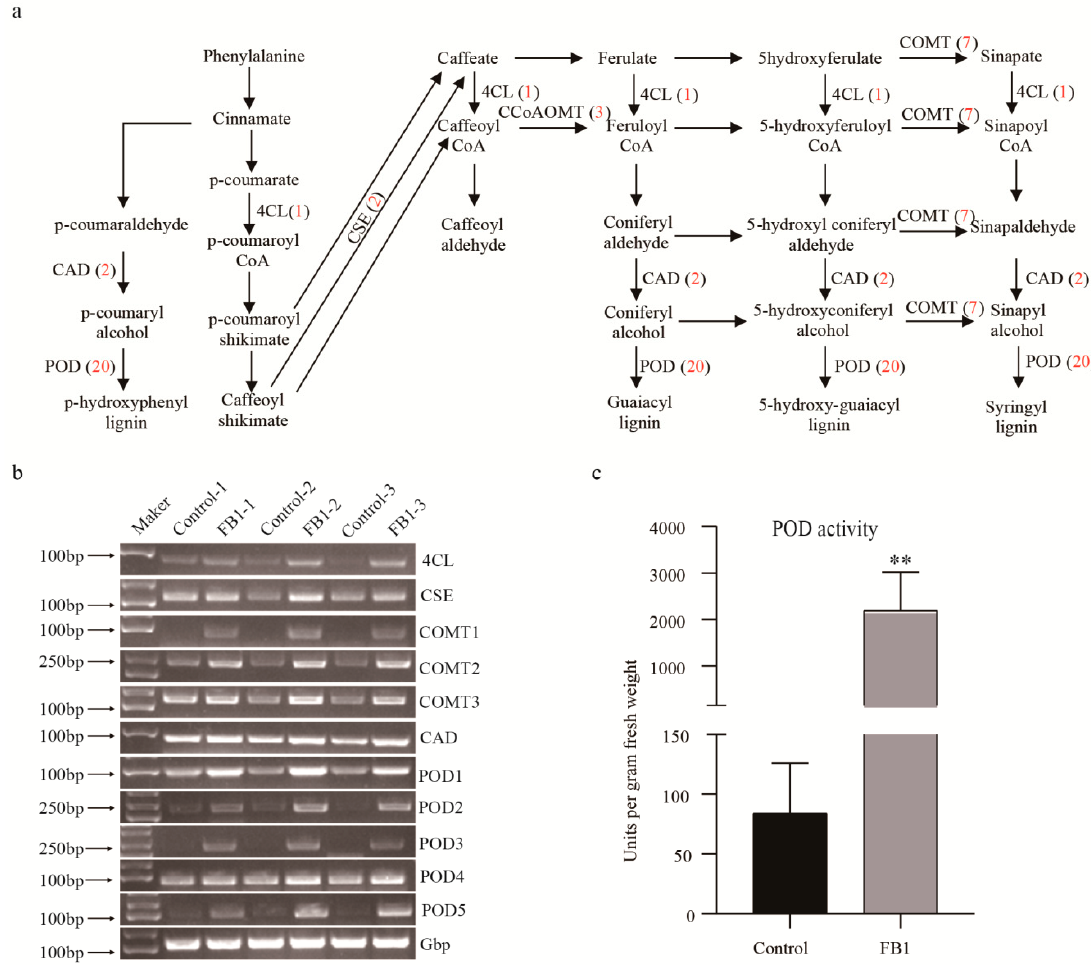
Figure 6. Involvement of the phenylpropanoid biosynthesis [33] in cotton fibers and ovules treated by FB1. ( a ) Up-regulated proteins from the phenylpropanoid biosynthesis pathway. The numbers in red represent proteins up regulated at the FB1 treated samples. ( b ) Semi-quantitative PCR of the phenylpropanoid biosynthesis-related genes in control and the FB1 sample. DL2000 DNA marker (left). Amplified genes of interest (right). ( c ) POD activity of control and the FB1 sample. Double asterisks indicate statistically significant differences between FB1 treatment and the control, as determined by Student’s t-test (**, p < 0.01).